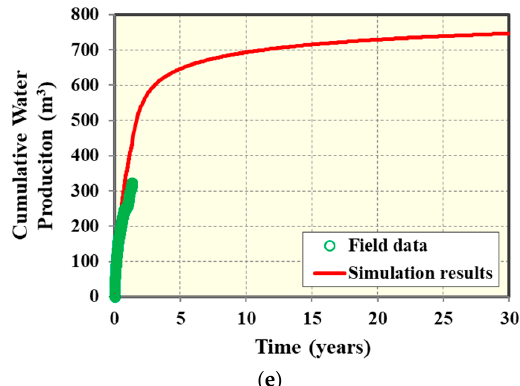
Figure 4. Production forecasting for 30 years incorporating the short-term filed production data: ( a ) Flowing BHP; ( b ) Gas flow rate; ( c ) Cumulative gas production; ( d ) Water flow rate; ( e ) Cumulative water production.